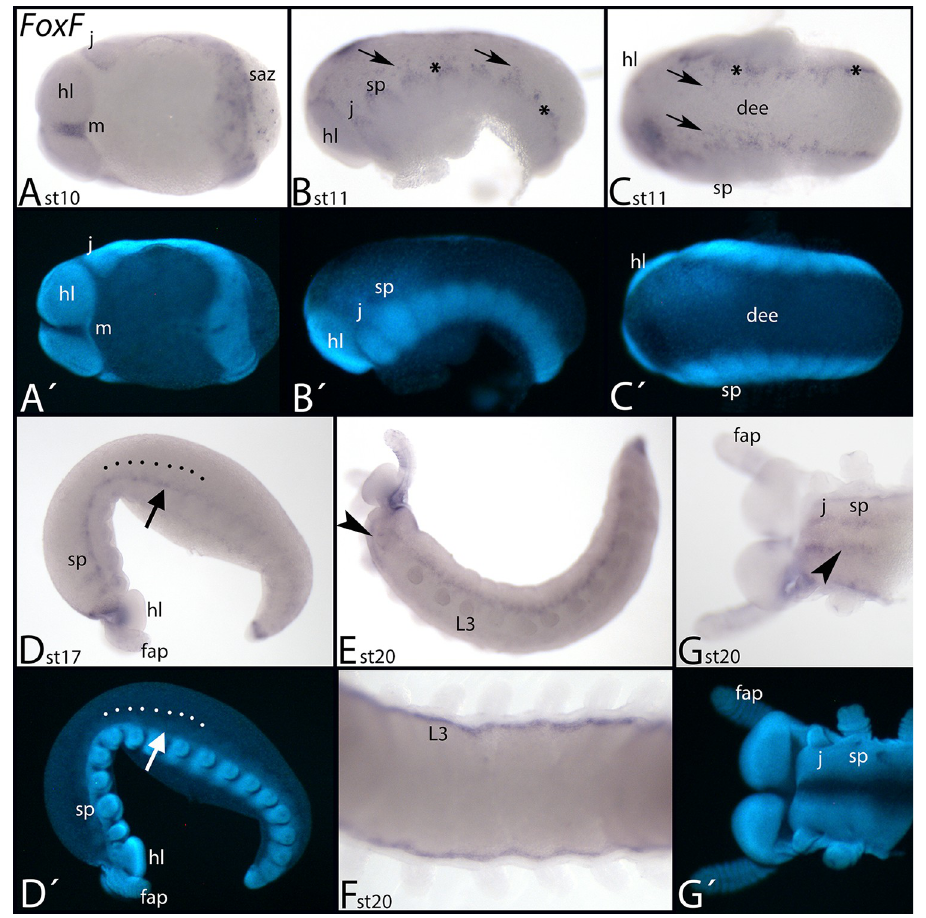
Fig 10. Expression of Euperipatoides FoxF . In all panels, anterior is to the left. Panels A and G, ventral view; panels B, D and E, lateral view; panels C and F, dorsal view. A´-D´ and G´ represent DAPI staining of the embryos shown in A-D and G. Arrow in panel D points to expression dorsally abutting the limb buds. Dashed line in panel D indicates dorsal margin of the germ band. Asterisks in panels B and C mark expression at the dorsal rim of the embryo; arrows in B and D point to expression in the dorsal extraembryonic tissue. Arrowheads in panels E and G mark expression in the ventral nervous system. Abbreviations in Table 2. dorsal in the second and third thoracic segment (arrows) (Fig 4G). Shortly after, additional dorsal expression appears in all abdominal segments (Fig 4H, arrow), the expression in the antennae becomes stronger, expression appears in the maxillae, and a spot of expression appears in the tip of the legs (Fig 4H). By the end of germ band retraction, the overall pattern is the same as described, with the exceptions that now several dorsal segmental spots are pres- ent (Fig 4I, asterisks), and that additional spots of expression appeared in the legs (Fig 4I). Glomeris FoxJ1 is expressed ubiquitously at all stages, but there is enhanced dot-like expres- sion in the ocular region at late developmental stages (Fig 8E–8H and S14B Fig). From stage 10.2 onwards, Parasteatoda FoxJ1 is expressed in a number of single cells or clusters of cells in all limbs, including the labrum, spinnerets and book lungs (Fig 13A–13G). See figure legend for further information. S15 Fig shows DAPI staining of the embryos shown in Fig 13. We did not detect expression of Euperipatoides FoxJ1 .